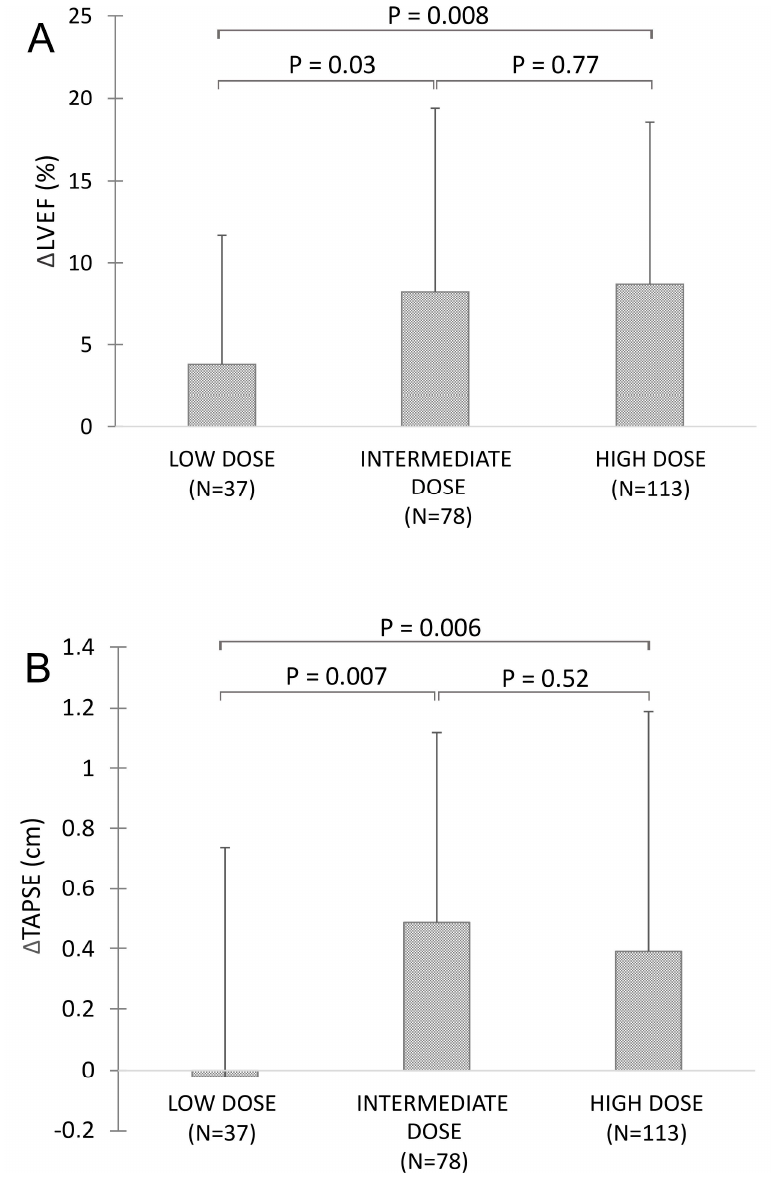
Figure 3. Effect of ARNI dose on ( A ) LVEF and on ( B ) TAPSE. Figure 3. E ff ect of ARNI dose on ( A ) LVEF and on ( B )